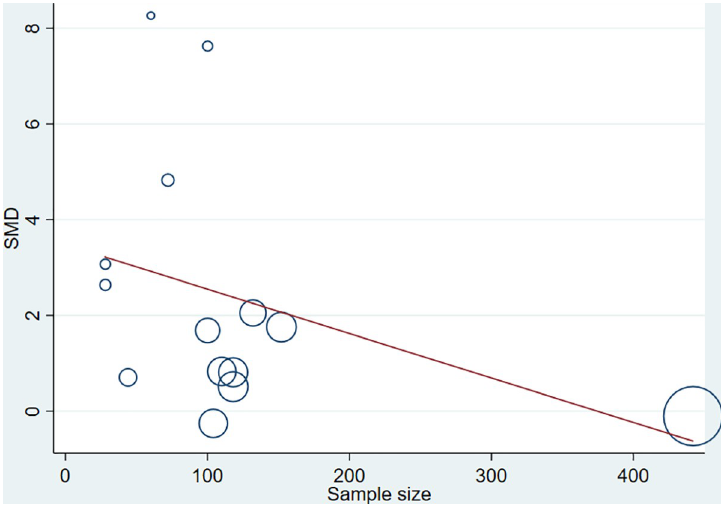
Fig 7. Bubble plot depicting the univariate meta regression of SMD with overall sample